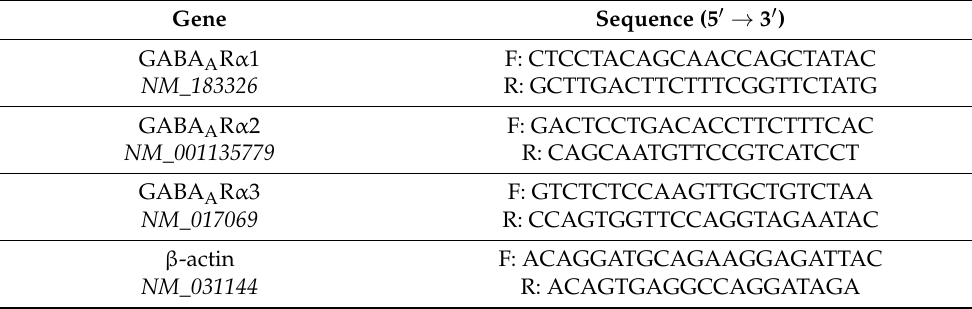
Table 1. Sequences of gene-specific